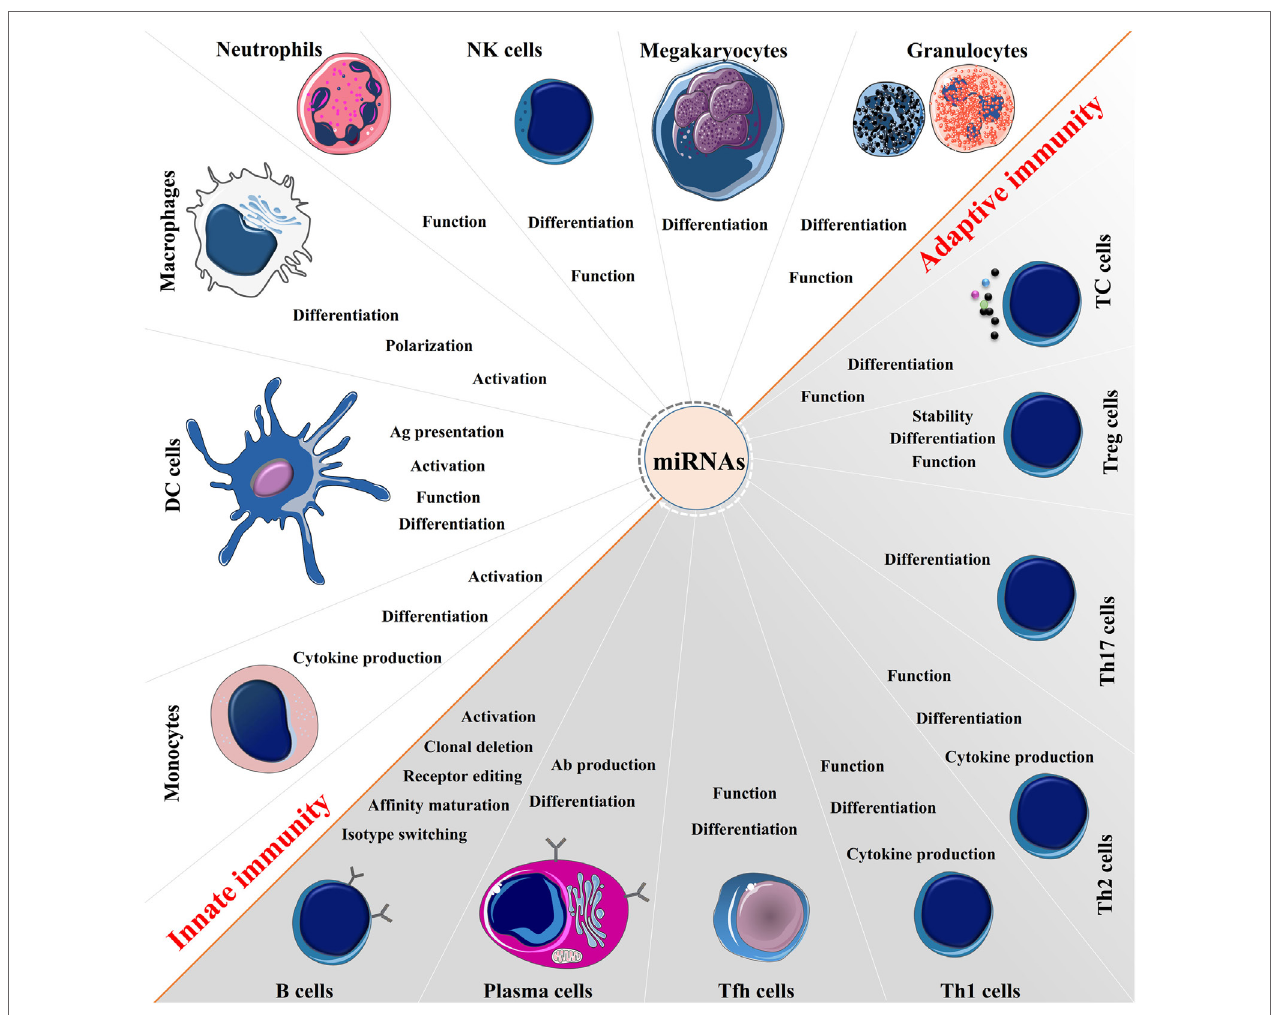
FigURe 2 | The broad function of microRNAs (miRNAs) in immune regulation. miRNAs are expressed in immune cells and function as “fine-tuners” for innate and adaptive immune responses. They establish an integrated part of the regulatory networks in innate immunity and regulate functions of immune cells such as monocytes, dendritic cells (DCs), macrophages, neutrophils, natural killer (NK) cells, megakaryocytes, and granulocytes. In adaptive immunity, they are implicated in every biological process including pathways involved in the T and B cells development, differentiation, central and peripheral tolerance, as well as their function.